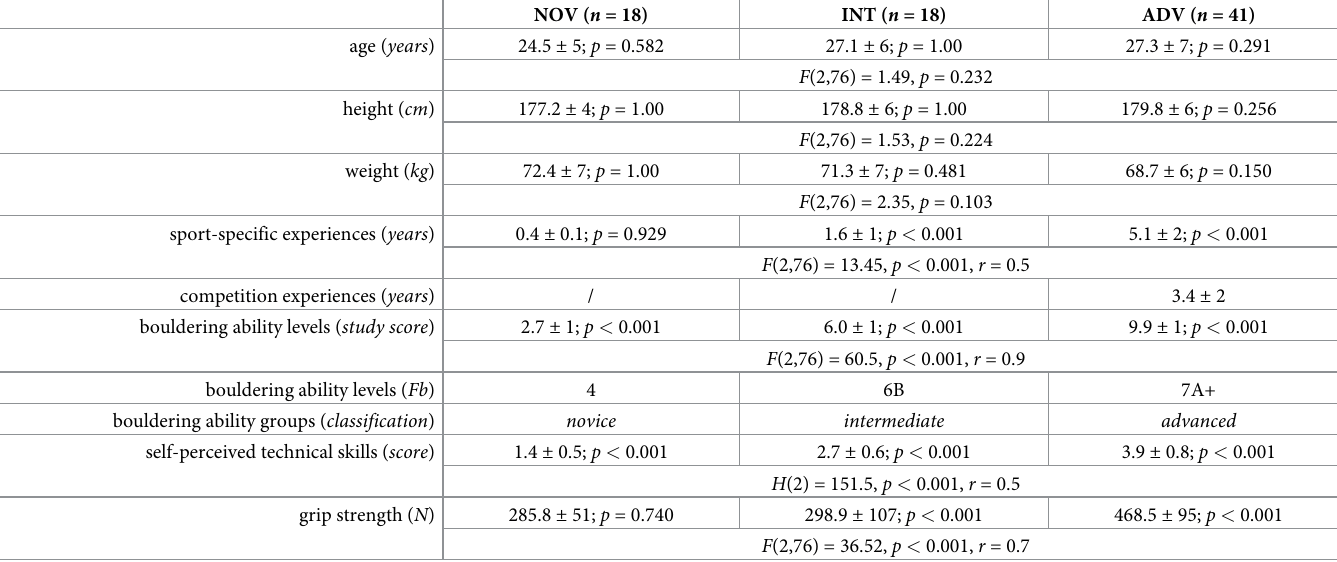
Table 1. Subject characteristics of the novice group (NOV), the intermediate group (INT), and the advanced group